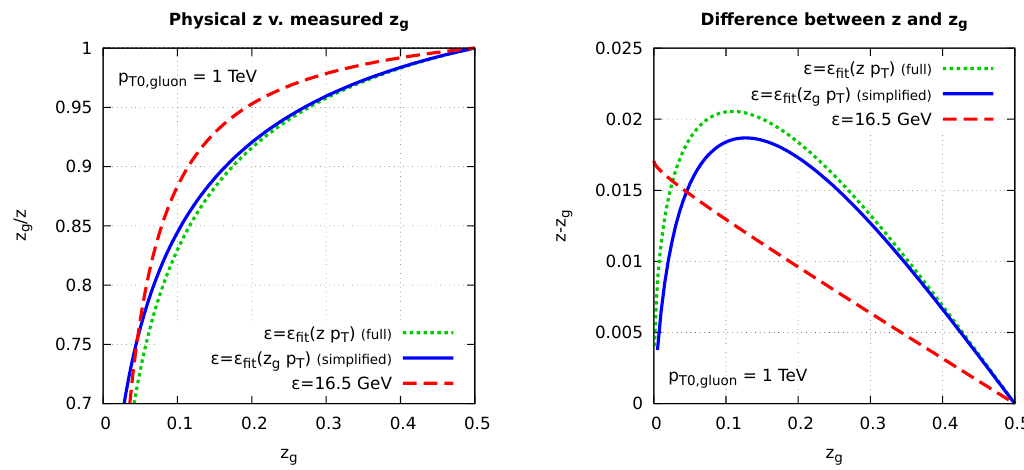
Figure 11 . The ratio z g =z (left (cid:12)gure) and the di(cid:11)erence z (cid:0) z g (right (cid:12)gure) between the splitting fraction z g measured by SD and the physical splitting fraction z for the hard splitting. This di(cid:11)erence is given by eq. (5.8) that we evaluate with two scenarios for the energy loss by the subjets: a constant energy loss and a p T -dependent one; for the second scenario, we also show the predictions of the simpli(cid:12)ed relation